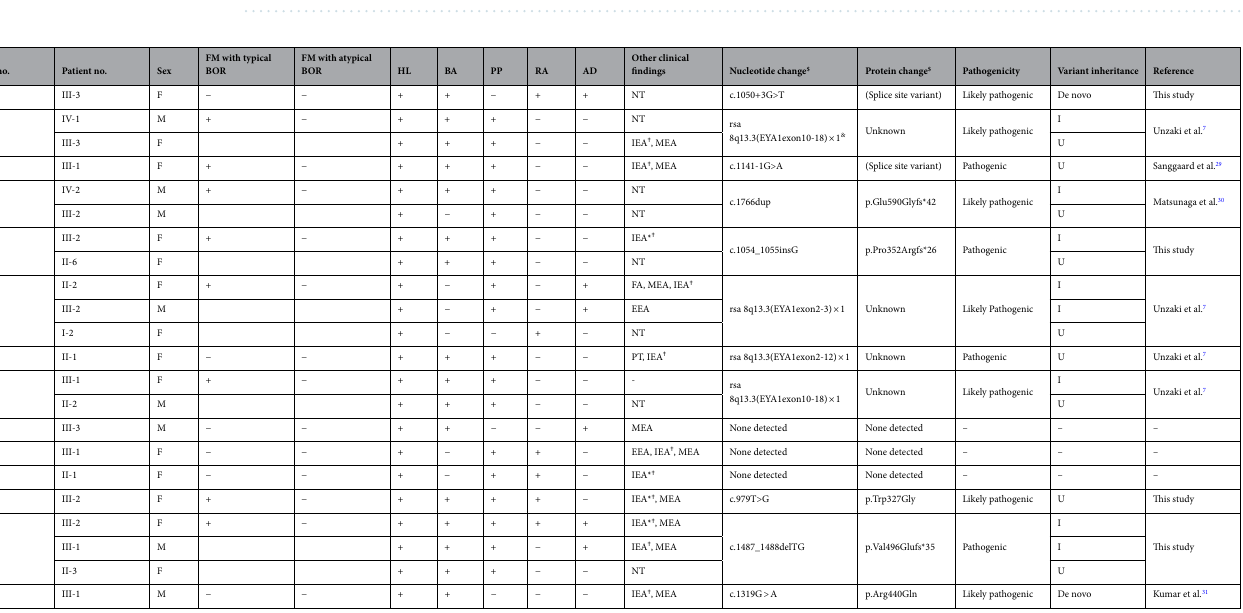
Table 1. Phenotypes and variants in patients with typical BOR syndrome. F female, M male, FM family member, HL hearing loss, BA branchial anomalies, PP preauricular pits, RA renal anomaly, AD auricular deformity, EEA external ear anomaly, FA facial asymmetry, IEA inner ear anomaly, MEA middle ear anomaly, NT not tested, PT preauricular tag, I inherited, U unknown. *Includes enlarged vestibular aqueduct. ✝ Includes cochlear hypoplasia. $ Reference sequences for nucleotide numbering and protein numbering are NM_000503.5 and NP_000494.2, respectively. & The results of MLPA are presented using the International System for Human Cytogenomic Nomenclature (2016) 29